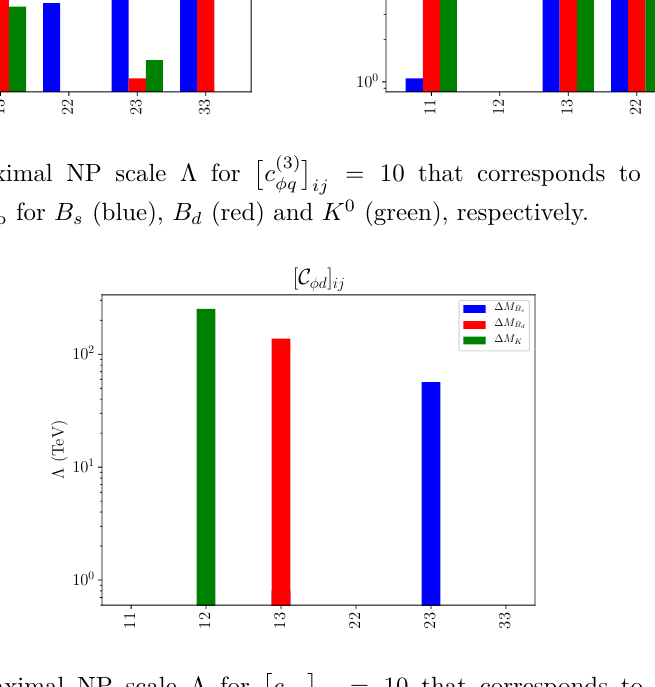
Figure 10 . The maximal NP scale Λ for (cid:2) (cid:3) M ij / (∆ M ij ) exp for B s (blue), B d (red) and K 0 (green), 2 12 BSM